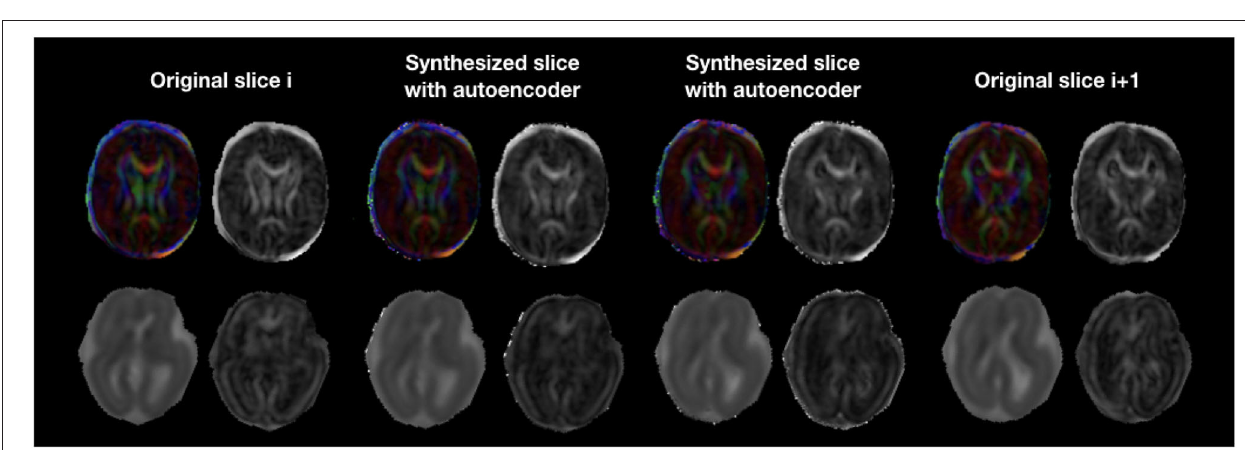
FIGURE 12 | Colored FA and FA (top row) illustration of autoencoder enhancement between two original adjacent fetal slices in a still subject (sub-1, 35 GW). The bottom row shows a similar illustration of MD and FA for a moving subject (sub-4, 23